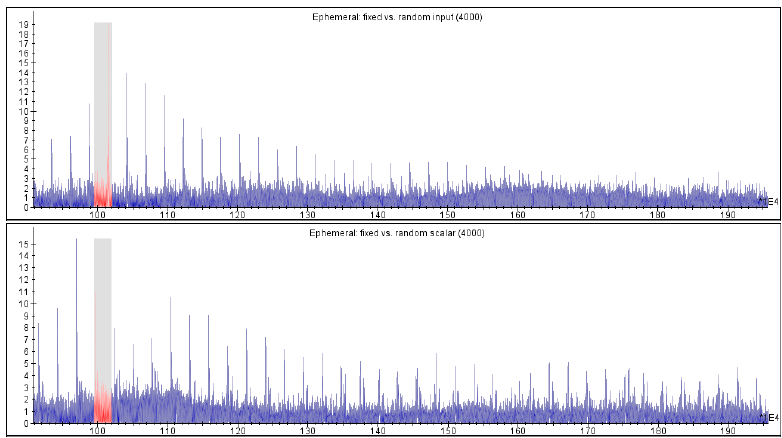
Figure 2: Ephem. imp. TVLA (0 . 9-2 . 0ms): fixed vs random point (top) & scalar